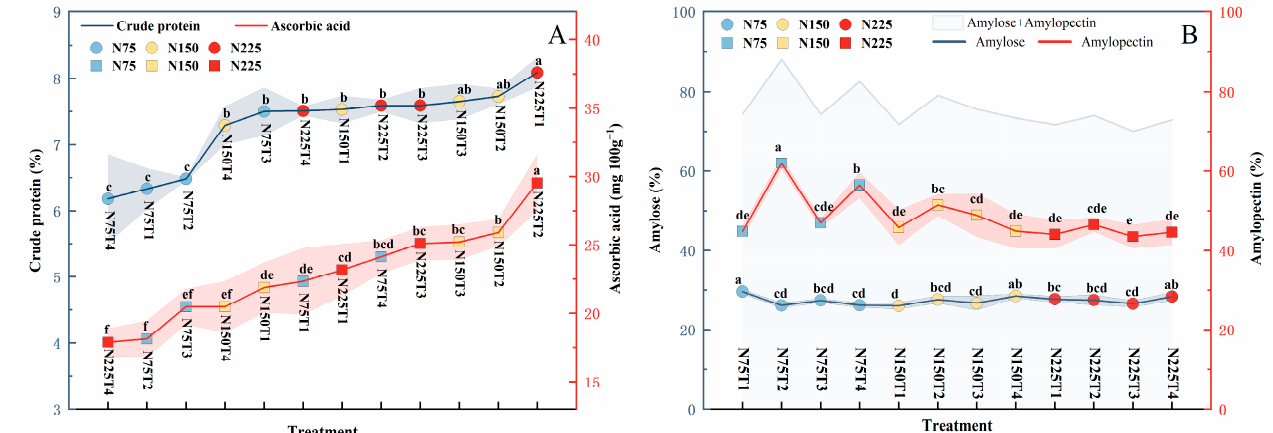
Figure 5. Tuber crude protein ( A blue) and ascorbic acid ( A red) content, tuber amylose ( B blue) and amylopectin ( B red) content, amylose added to amylopectin Broken lines show mean value, shade along the broken line indicates standard errors ( n = 3), different lowercase letters. The results of the study show that the mean value of N75 in blue was higher than that of N75 in blue. Balls of N75 in blue, N150 in yellow, and N225 in red are sorted by size in ( A ), but by N management in ( B ). With N usage increased, the average single potato weight decreased (Table 3). N225 Table 3. Effects of different treatments on potato yield components and was signi fi cantly ( p < 0.05) lower than N150 by 4.19%, while the number of potatoes per plant increased, N225 was higher than N150 and N75 by 3.33% and 7.26%, respectively, at p < 0.05 levels. The average yield under N150 was the highest, signi fi cantly ( p < 0.05) higher than N75 and N225 by 2143.85 kg ha − 1 and 2016.61 kg ha − 1 , respectively. T3 and T4